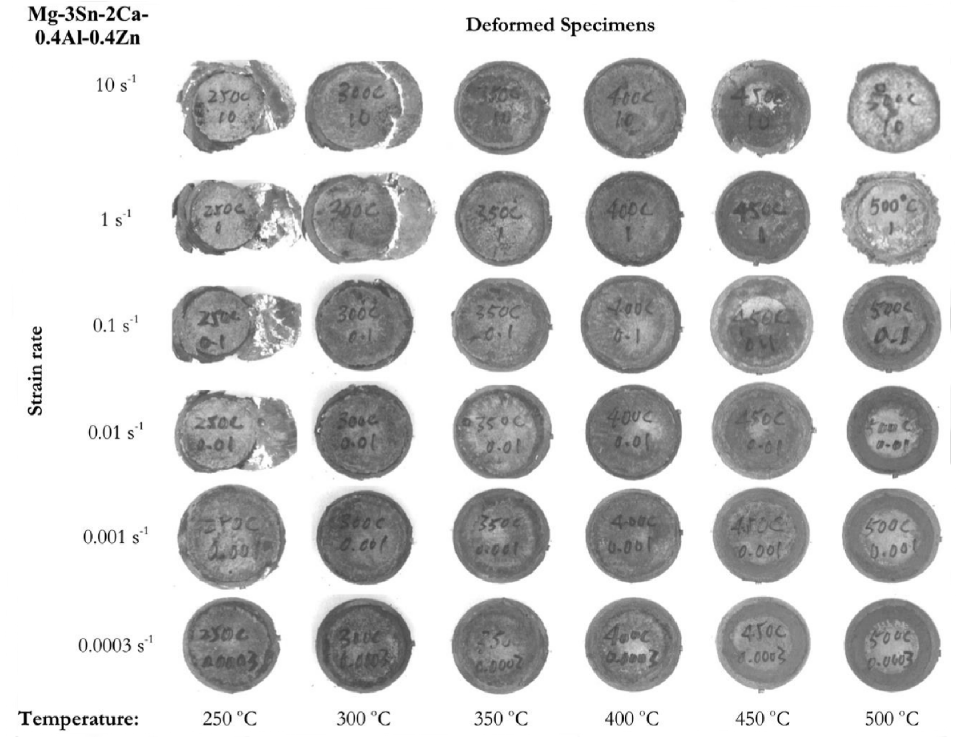
Figure 7. Specimen shapes after the hot compression of TXAZ3200 alloy at different temperatures and strain